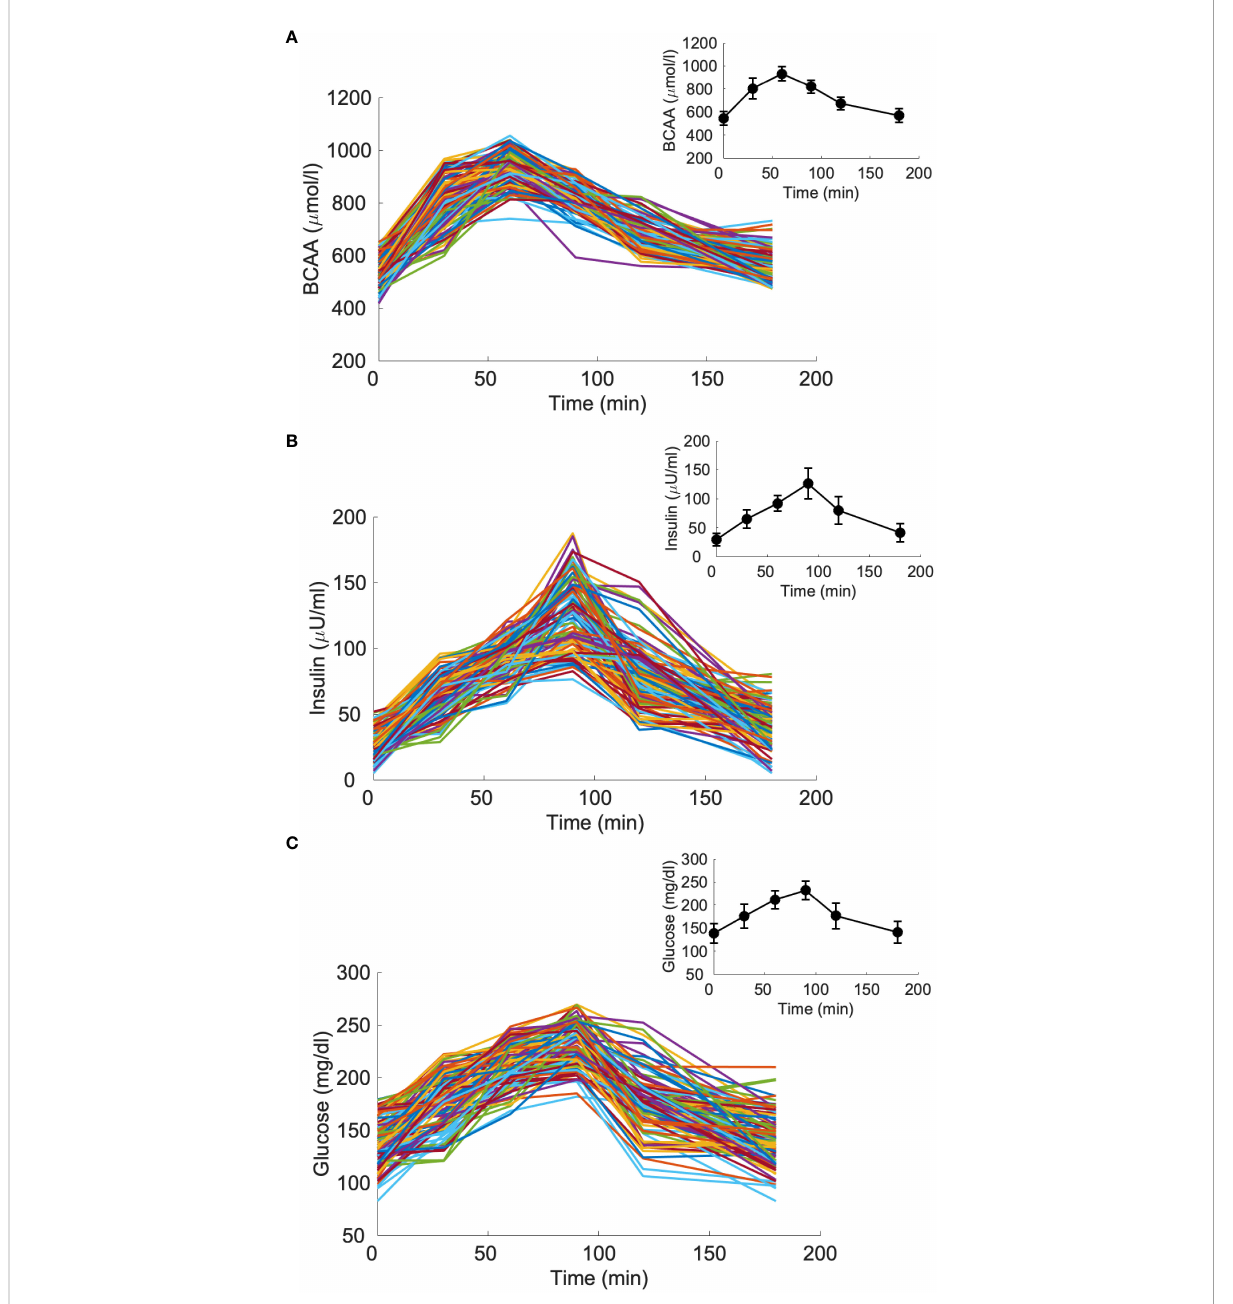
FIGURE 6 Branched-chain amino acids (BCAA), insulin and glucose curves for the virtual population composed by 100 individuals with type 2 diabetes (T2D, “ spaghetti plot ” in panels A – C ); BCAA, insulin and glucose mean (± SD) computed over the 100 curves (black lines in the inset